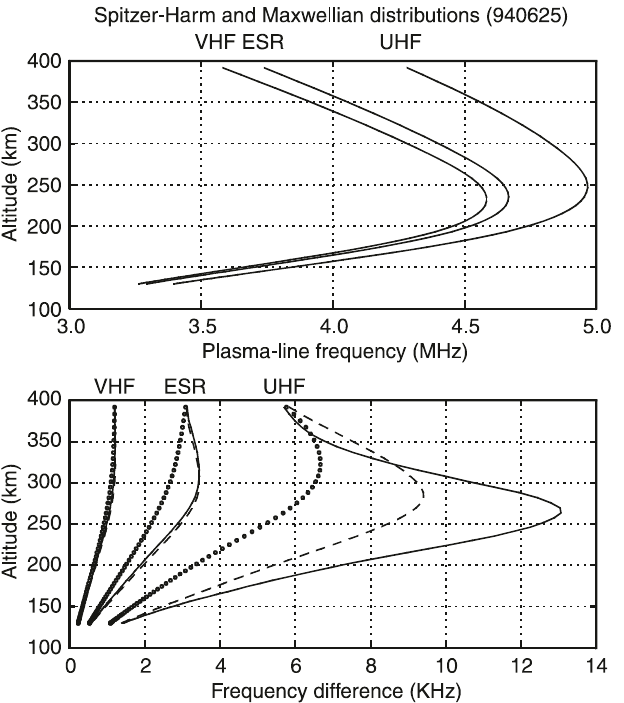
Fig. 12. The upper plate presents the calculated upshifted plasma frequency for the Spitzer-Ha¨ rm distribution for the three di(cid:128)erent EISCAT radars. In the lower plate we present the frequency di(cid:128)erence between up- and downshifted lines for the three radars. The Maxwellian approximation is shown with circles , the full two- dimensional dispersion estimation is the solid line and the heat flow approximation (Kofman et al. , 1993) is shown with the dashed line